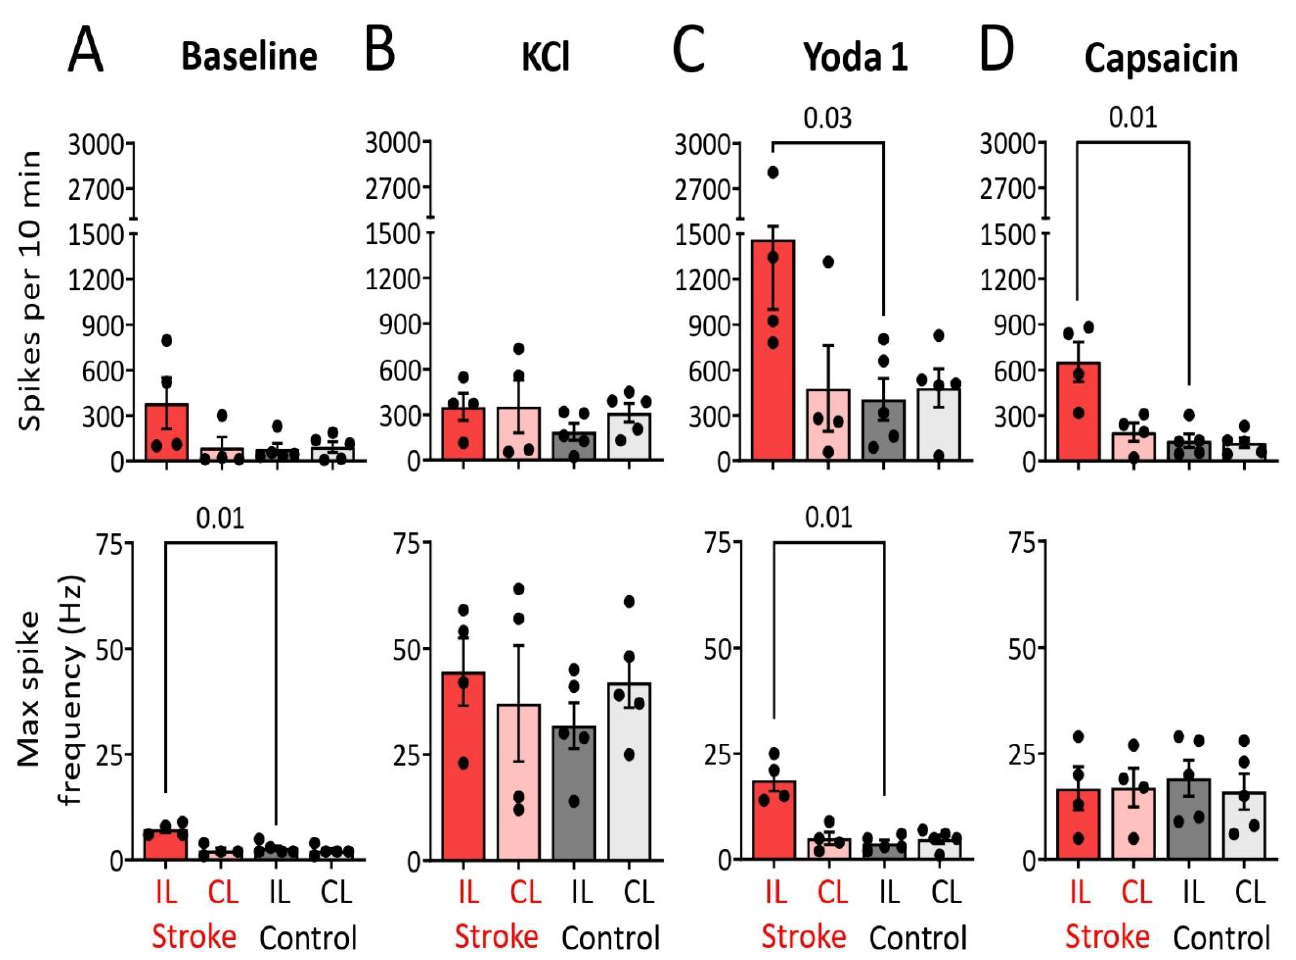
Figure 4. Histograms (top) depict the number of nociceptive spikes during 10 min recording (baseline) for the ipsilateral (IL) and contralateral (CL) hemi-skulls in the ischemic stroke and control groups. Histograms (bottom) depict the mean number of maximal spike frequency at baseline for the IL and CL hemi-skulls in the ischemic stroke and control groups. Notice the maximal spike frequency is higher in the IL hemi-skulls of the ischemic stroke group compared to those in the control group ( p = 0.01) ( A ). Histograms (top) depict the number of nociceptive spikes during 10 min recordings after 50mM KCL application for the IL and CL hemi-skulls in the ischemic stroke and control groups. Histograms (bottom) depict the number of maximal spike frequency during 50mM KCL for the IL and CL hemi-skulls in ischemic stroke and control groups ( B ). Histograms (top) depict the number of nociceptive spikes during 10 min recordings after application of 5 μM Yoda1 for the IL and CL hemi-skulls in the ischemic stroke and control groups. Of note, firing is increased in the IL hemi-skulls of the ischemic stroke group compared to the corresponding hemi-skulls of the control group ( p = 0.03). Histograms (bottom) depict the number of maximal spike frequency during application of 5 μM Yoda1 for the IL and CL hemi-skulls in the ischemic stroke and control groups, where maximal spike frequency is higher in the IL hemi-skulls of the ischemic stroke group compared to those in the control group ( p = 0.01) ( C ). Histograms (top) depict the number of nociceptive spikes during 10 min recordings after application of 1 μM capsaicin for the IL and CL hemi-skulls in the ischemic stroke and control groups. Notice that in the IL hemi-skulls of the ischemic stroke group, capsaicin induces nociceptive firing continuously throughout entire 10 min, increasing the number of spikes compared to the IL hemi-skulls of the control group ( p = 0.01). The bottom histograms depict the mean number of maximal spike frequency during 1 μM capsaicin application for the IL and CL hemi-skulls in the ischemic stroke and control groups ( D ). Data are mean ± SEM.